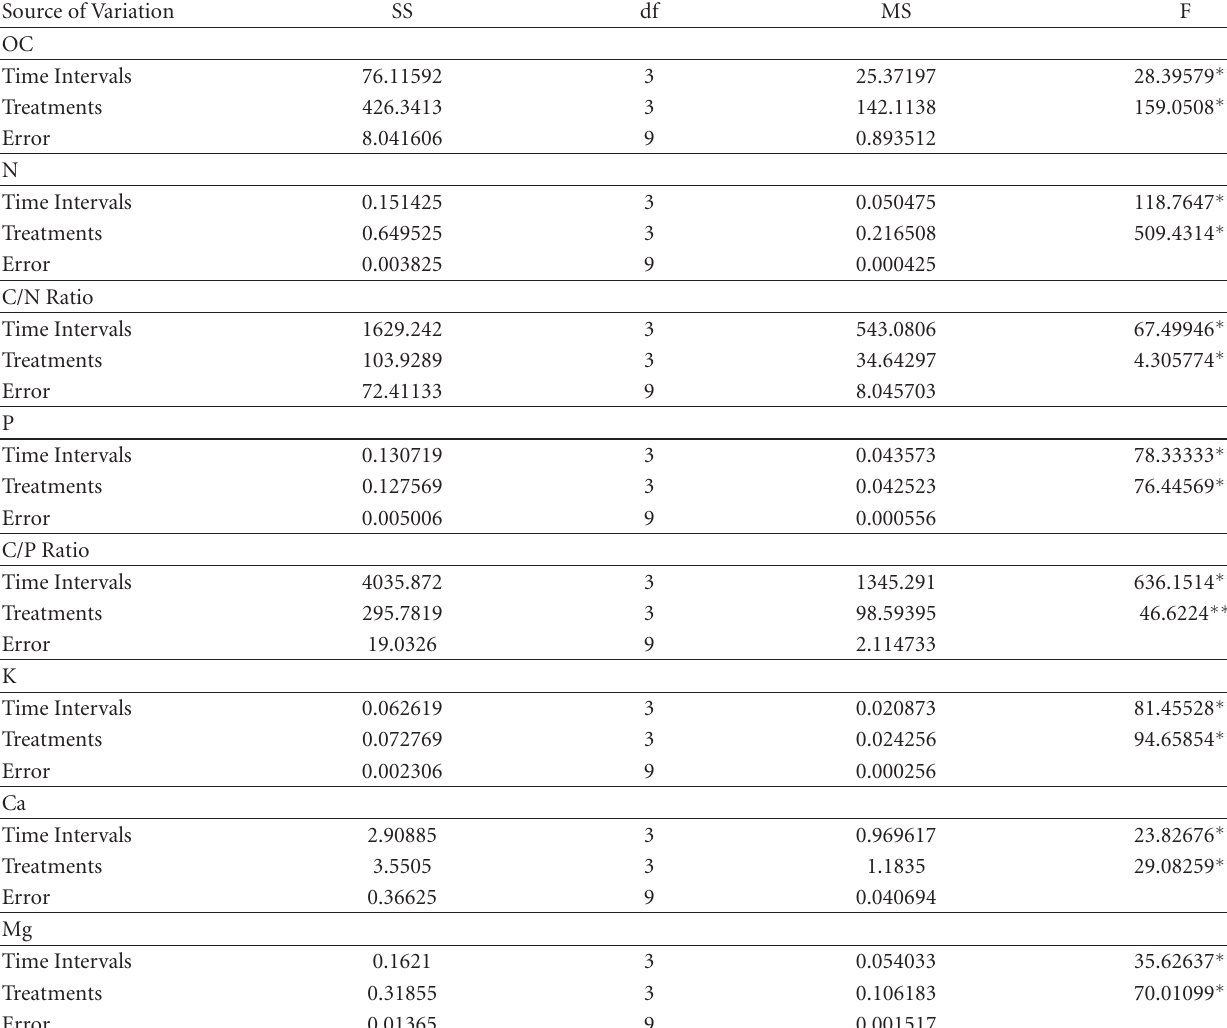
Table 4: ANOVA of di ff erent nutrients of vermicomposts produced by three species of earthworms and compost (Treatments) of Floral Waste across di ff erent time